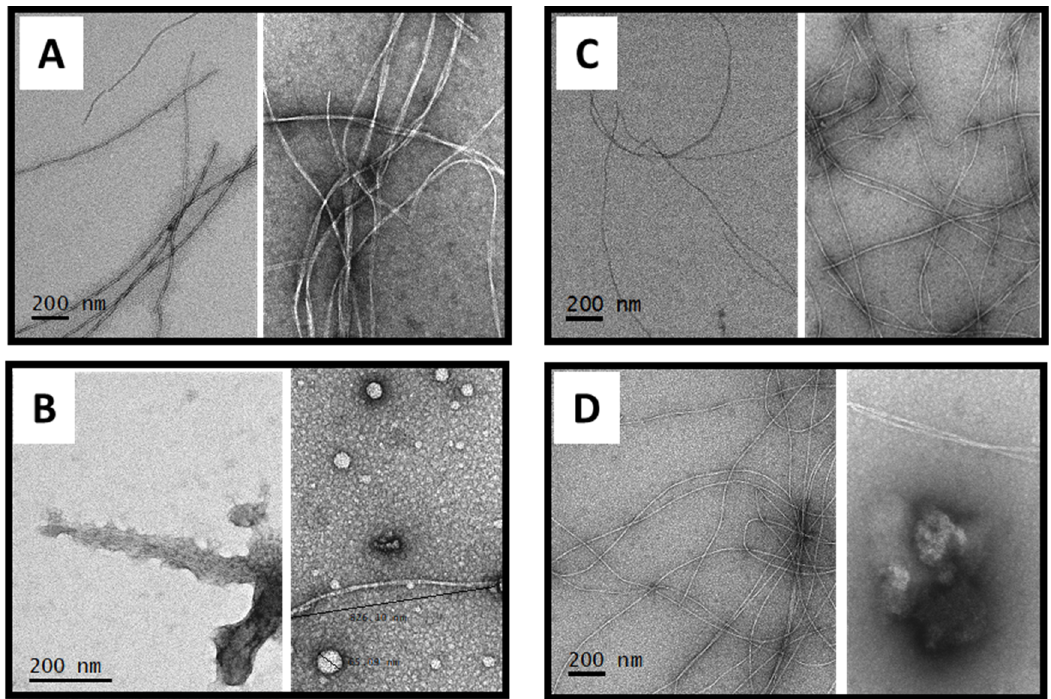
Figure 1. Kinetic monitoring of A β 1–40 and ox A β 1–40 co-assembly using ThT fluorescence for 4 independent experiments. Curves are shown as triplicate. [A β 1–40 ] = 20 µM (black); [ ox A β 1–40 ] = 20 µM (blue); [A β 1–40 ] = [ ox A β 1–40 ] = 10 µM (green) and [A β 1–40 ] = 10 µM (red). Experiment N°1 ( A ), N°2 ( B ), N°3 ( C ) and N°4 ( D ). Hepes buffer 50 mM, [NaCl] = 65 mM, pH 7.0 (except 7.4 for experiment N°3). Y-axis corresponds to ThT fluorescence in arbitrary unit (a.u.); data are directly comparable between them (same y-scale).